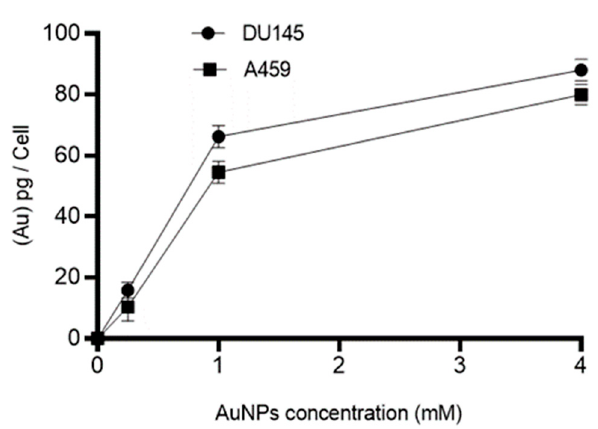
Figure 1. Inductively coupled plasma mass spectrometry (ICP MS) results of cellular uptake of gold nanoparticles (AuNPs) in human cancer cells. The ICP MS intensities were converted to mass of AuNPs per cell by using Au ion standard curve and cell count. No AuNPs were detected in control cells. Results are expressed mean ± standard error of the mean (SEM) of 3 replicates.